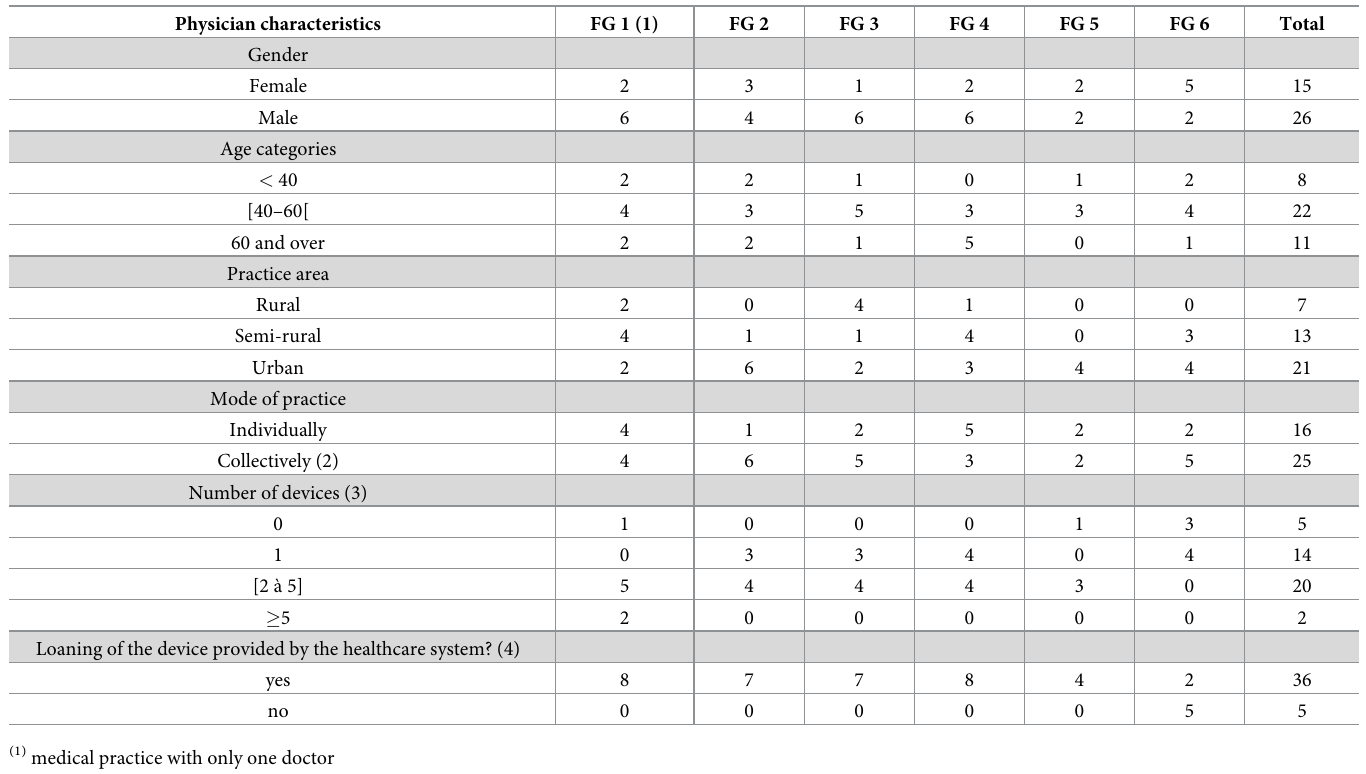
Table 2. Characteristics of participating GPs. Physician